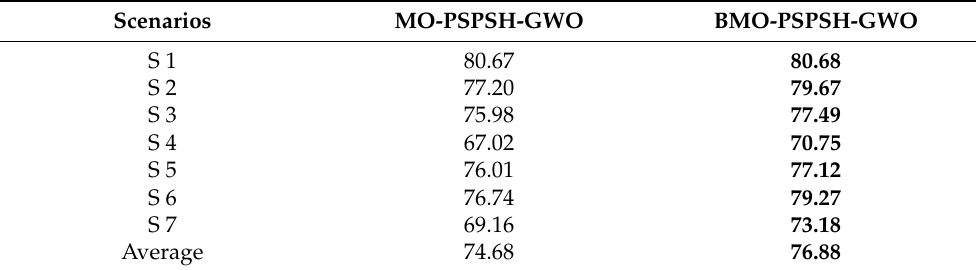
Table 10. Comparison between MO-PSPSH-GWO and BMO-PSPSH-GWO in terms of user comfort (UC) percentage